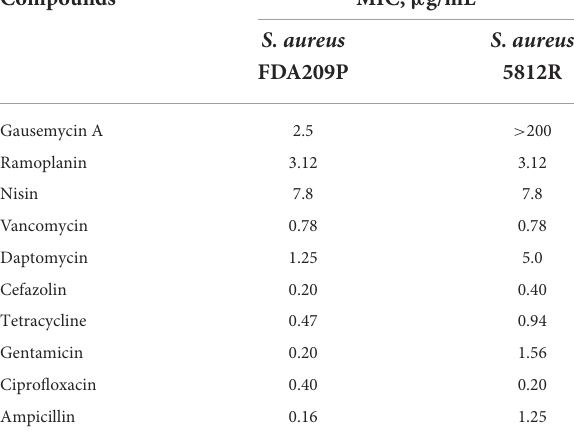
Compounds MIC, µ g/mL